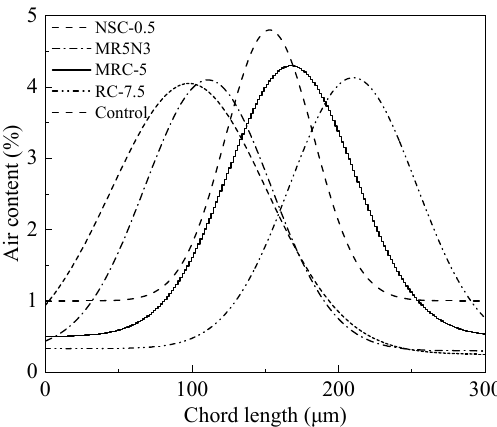
Figure 10. Air content of concrete.